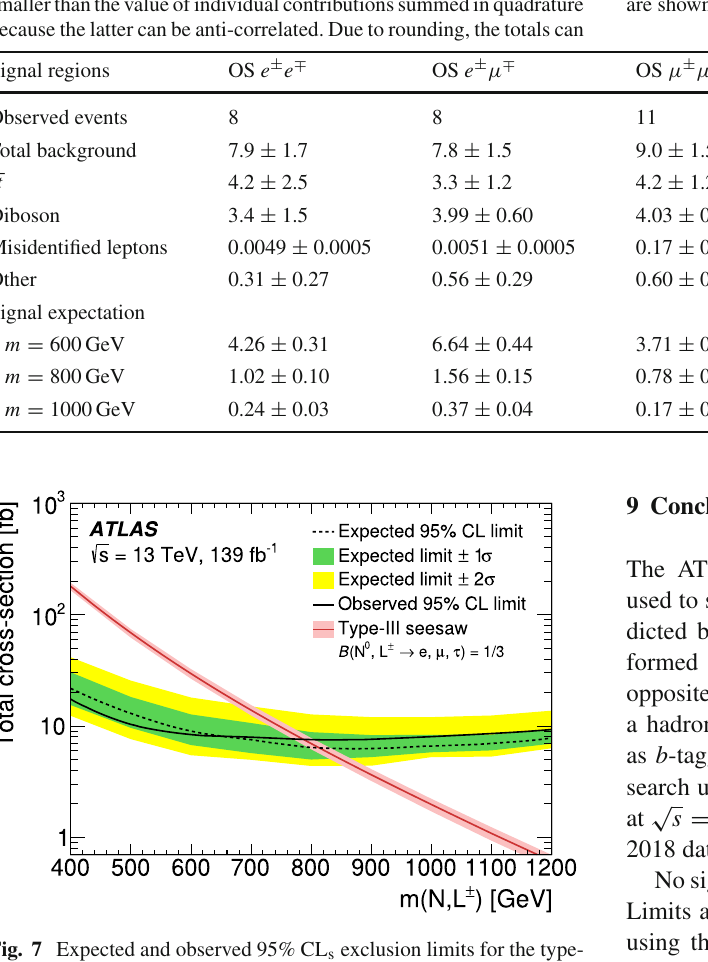
differ from the sums of components. The t ¯ t and diboson normalisations are allowed to float in the fit. As a reference, representative signal yields andtheirerrorsforsignalmasses m ( N 0 , L ± ) ,denotedby m inthetable, are shown in the bottom part of the table